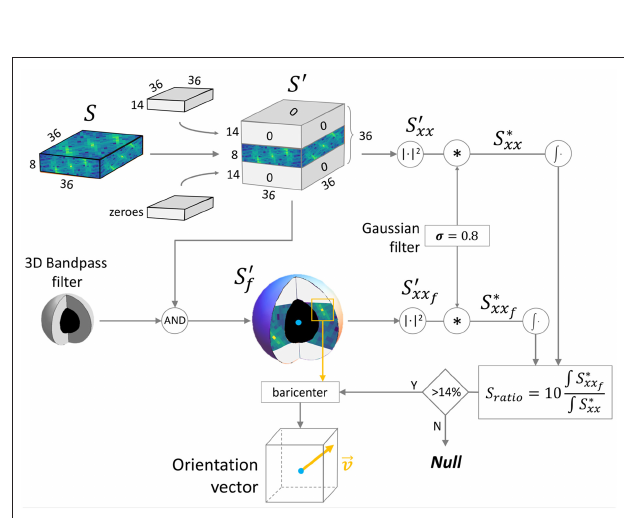
FIGURE 2 | 3D spectrum manipulation pipeline. The scheme shows the frequency analysis approach developed to evaluate the reliability of the Z-bands signal and to extract the 3D orientation. S : frequency spectrum of a 16 16 16 µ m virtual sample chunk; S ′ : spectrum with isotropic voxel × × resolution; S ′ f : filtered spectrum; S ′ xx and S ′ xx : power spectrum densities. f